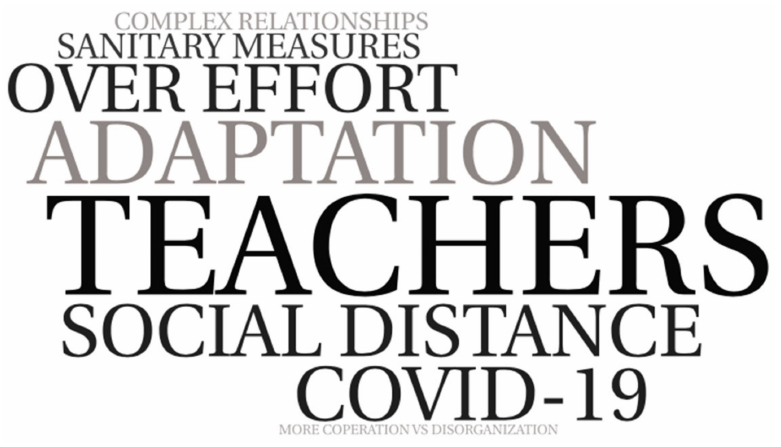
Figure 4. World cloud alluding to arguments in relation to teachers. Self-made